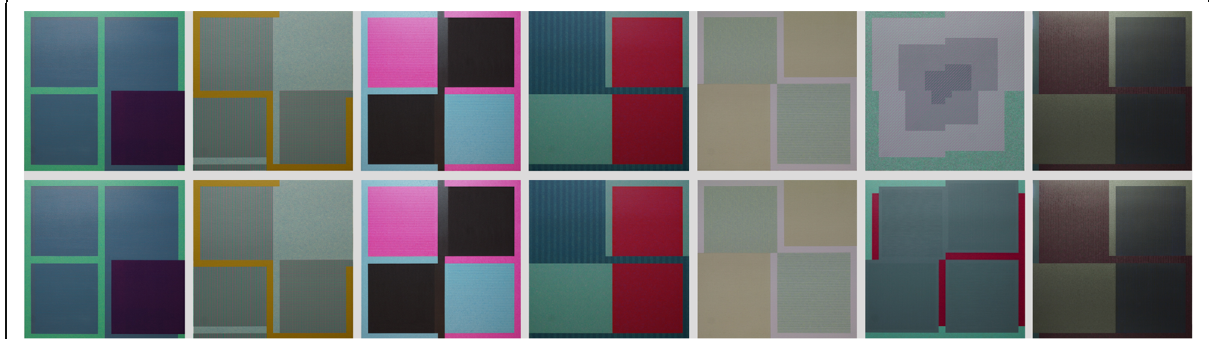
Fig. 9 Example of two partially synonymous sets of images; artist: Frieder